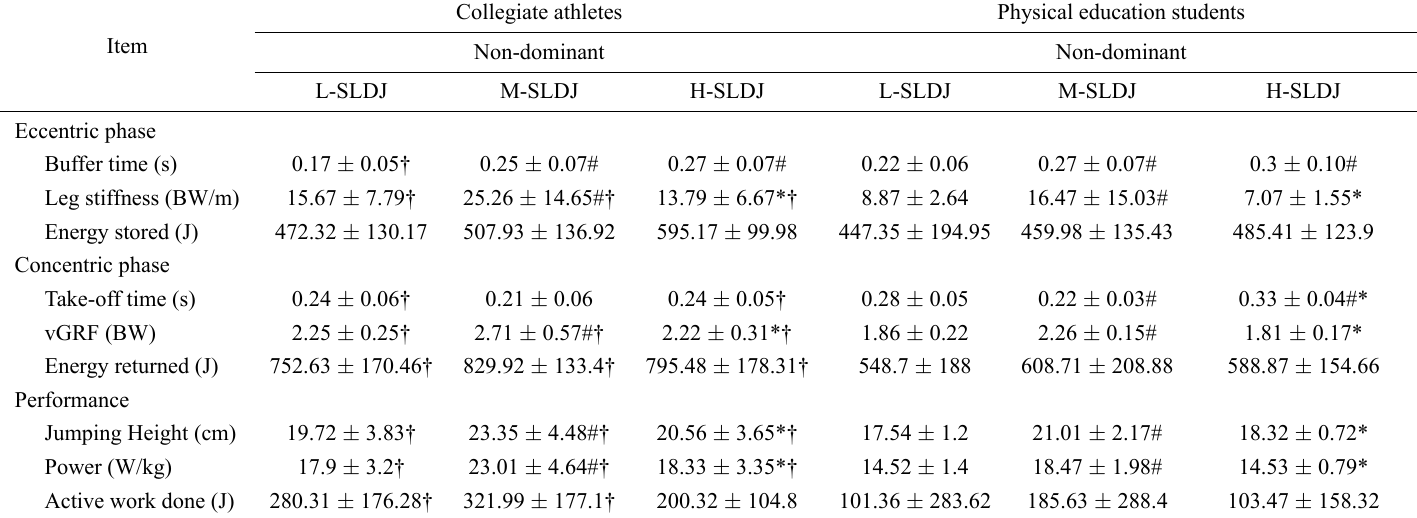
Table 3. Data during the SLDJ testing for male non-dominant leg with different exercise